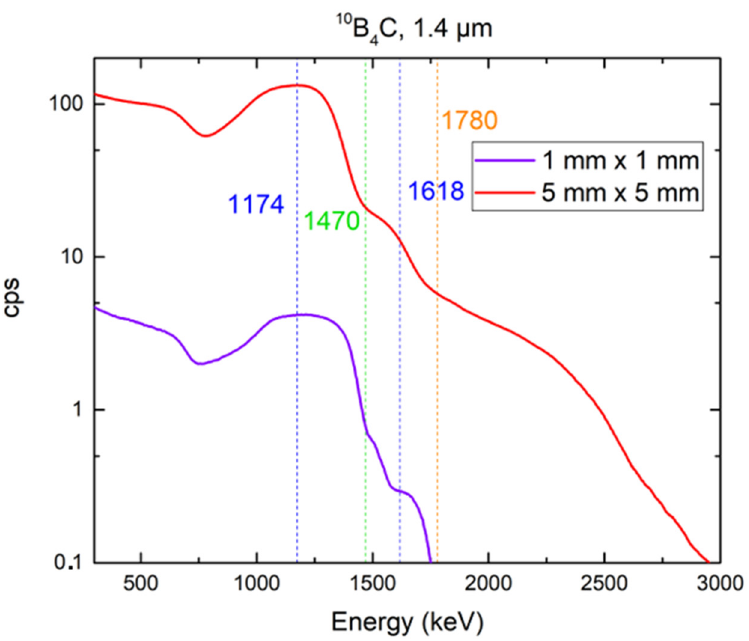
Figure 8. Comparison of the responses of 4H-SiC SBD detectors with different active areas (1 mm × 1 mm and 5 mm × 5 mm) equipped with a 1.40 µm thick 10 B 4 C thermal neutron converter layer with different thicknesses to the neutron field of a JSI TRIGA reactor at 250